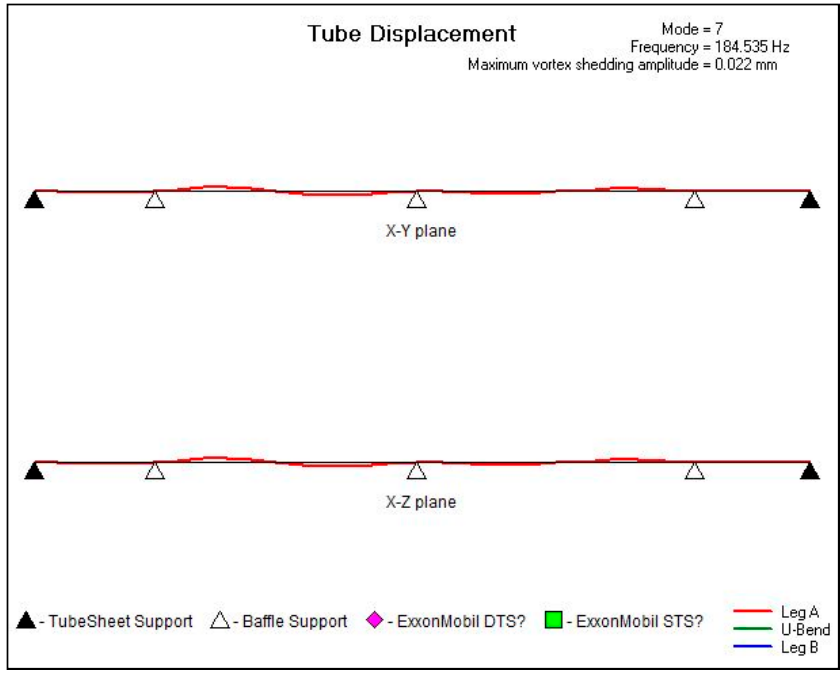
Figure 11. Tube displacement profiles of modes 7 and 8, 184.54 Hz.